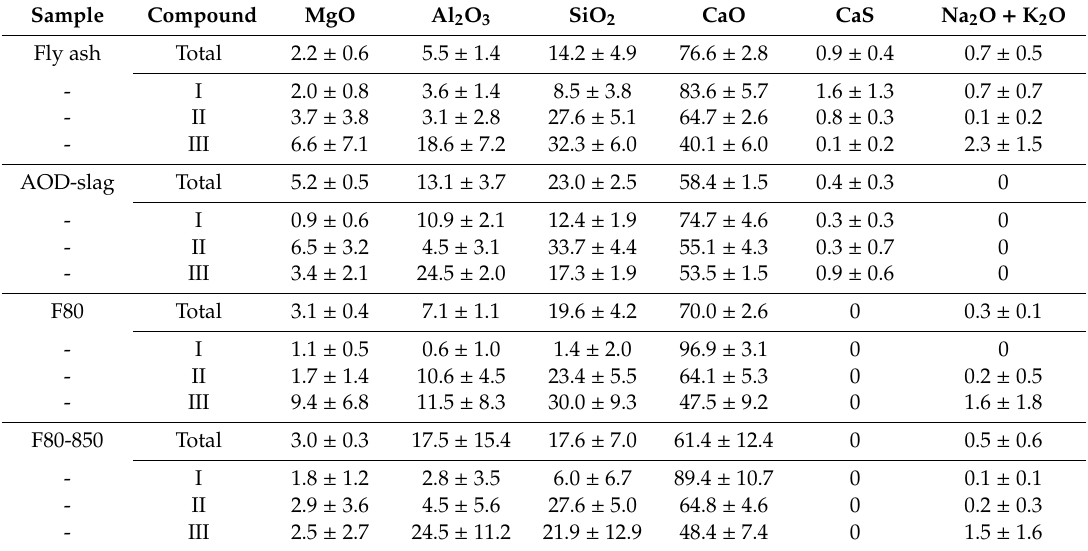
Table 2. Average contents (in mass%) and standard deviations of main components in di ff erent types of compounds in analyzed material samples.